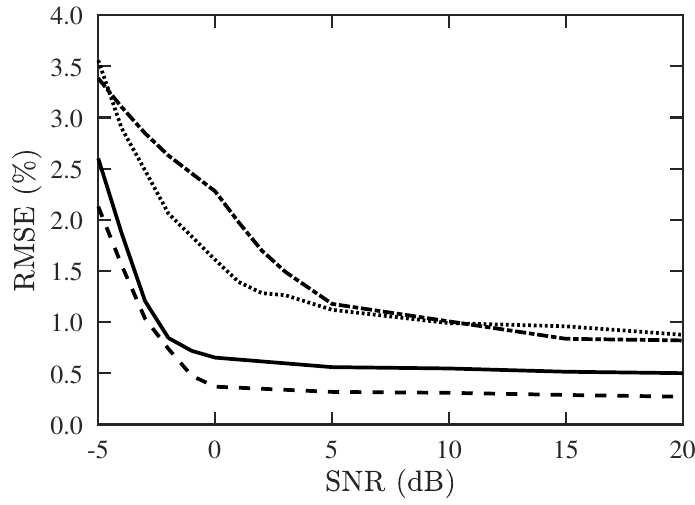
Figure 12. RMSE of DOA and CF estimation versus SNR, with proposed PJE algorithm, Q = 300, M = 30. ———: RMSE of DOA with M u = 10, − − − : RMSE of CF with M u = 10, − · − : RMSE of DOA with M u = 13, · · · : RMSE of CF with M u = 13.